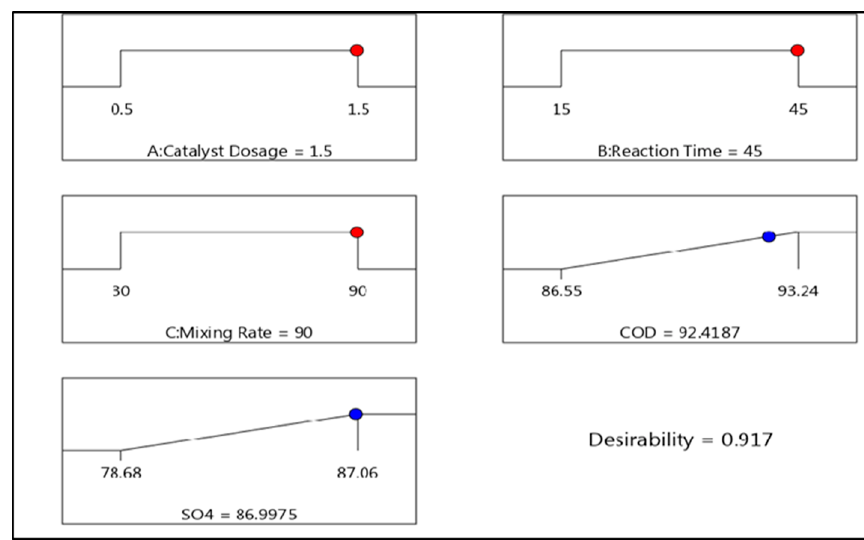
Figure 9. Optimum operating conditions for TiO 2 .